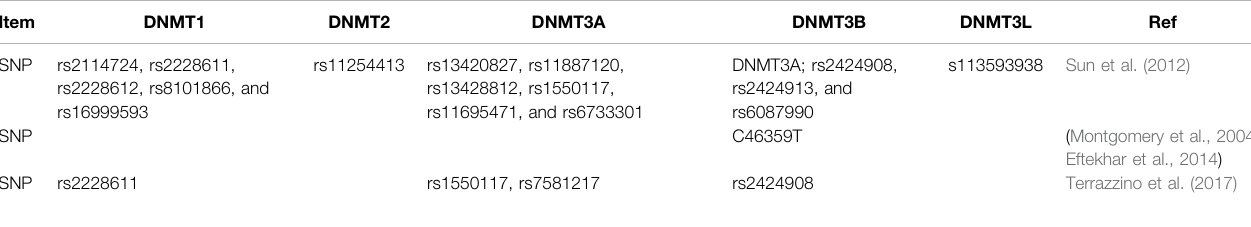
TABLE 1 | SNP of DNMT in breast